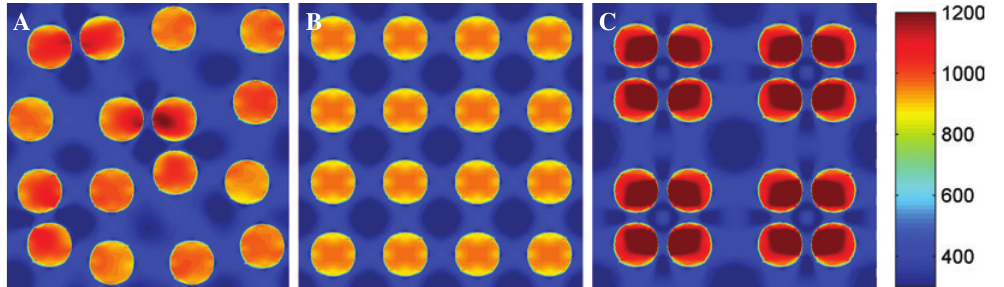
Figure 10: Effective stress distributions at applied transverse strain of 1.5% and strain rate of 0.1/s for (A) random, (B) square, (C) cluster- ing fiber arrays.